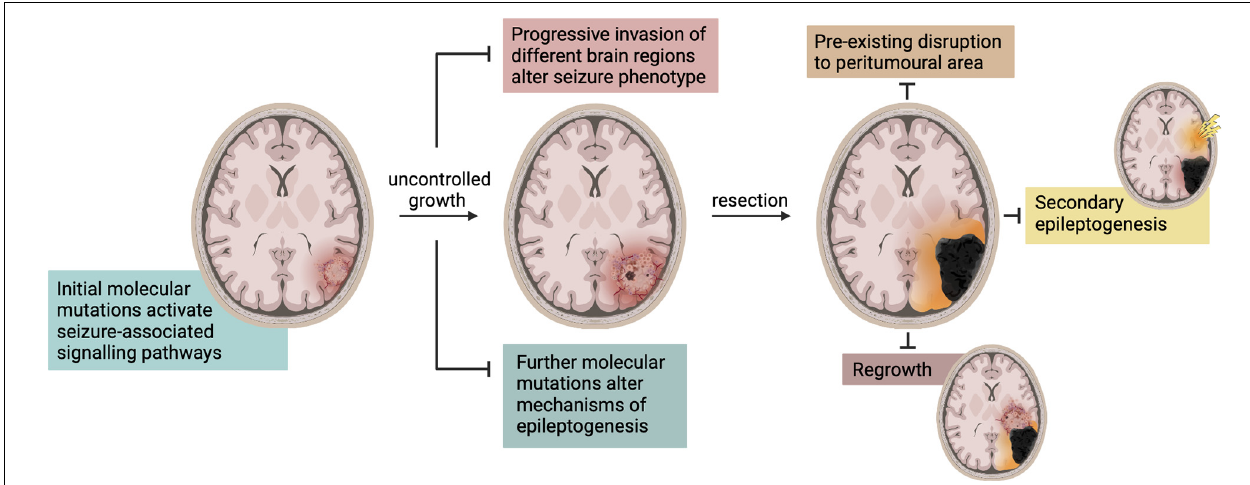
FIGURE 3 | Changes in seizure characteristics during disease progression and treatment. There are a multitude of mechanisms that alter seizure characteristics and phenotype in GBM. The molecular mutations and consequently activated signaling pathways change throughout its progression and as it enters new areas of the brain. Upon resection, these mechanisms are altered again and often accompanied by a period of seizure cessation. Seizures may then be produced in the peri-cavity region due to pre-existing network disruption or tumor regrowth, or in an entirely different region due to secondary